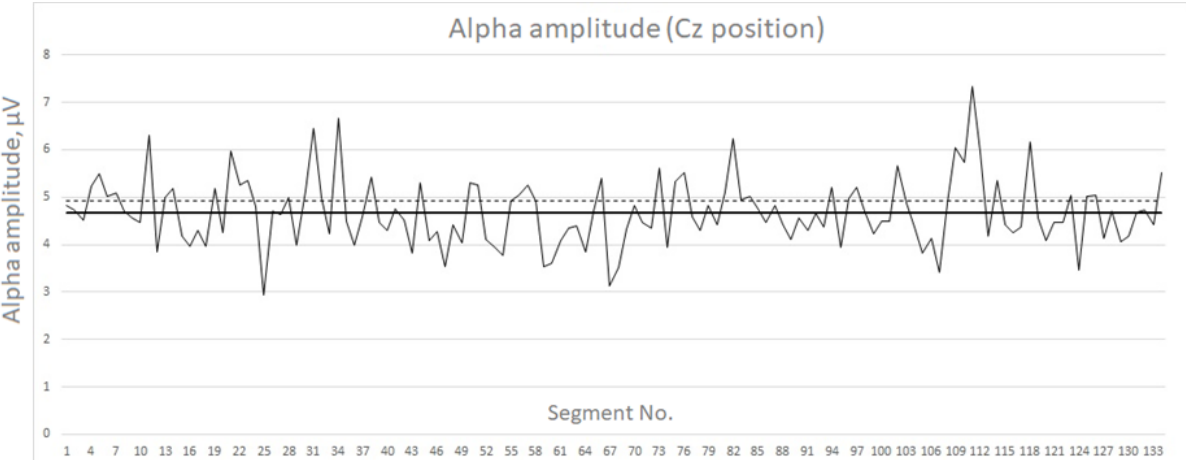
Figure 4. Alpha amplitude (μV) segment plot for the VR/MR educational episode for the Cz position. MR: mixed reality; VR: virtual